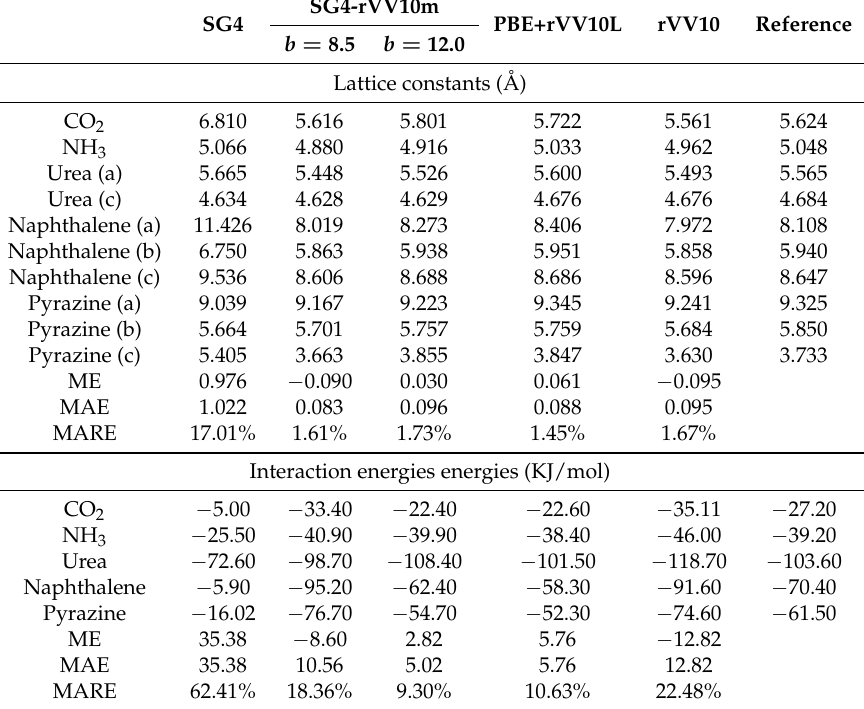
Table 4. Lattice constants and cohesive energies of several molecular crystals as obtained with different functionals. The reference values are taken from References [67–71]. For each property, we also report the mean error (ME), the mean absolute error (MAE), and the mean absolute relative error